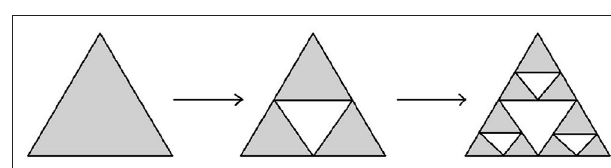
FIGURE 15 | Construction of Sierpinski triangle.